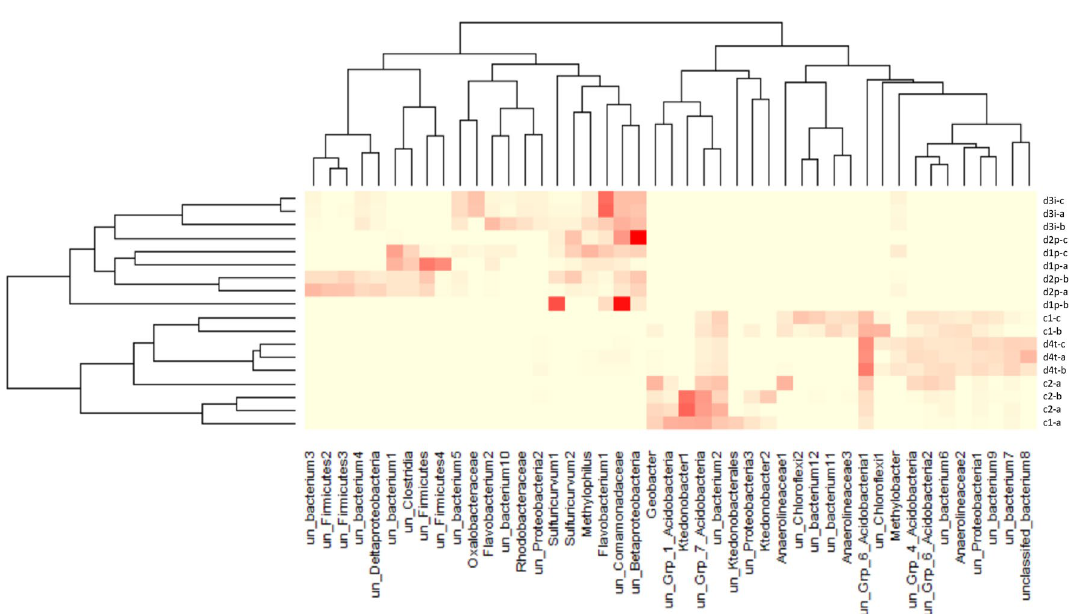
Figure 3. Heatmap showing the distribution of OTU within each replicate sample. Replicate samples are shown with -a, -b and -c. Data is simplified so that OTU are only depicted if they contribute more than 1% of a single sample. Dark red = 1, pale yellow = 0. Within OTU names ‘un’ =